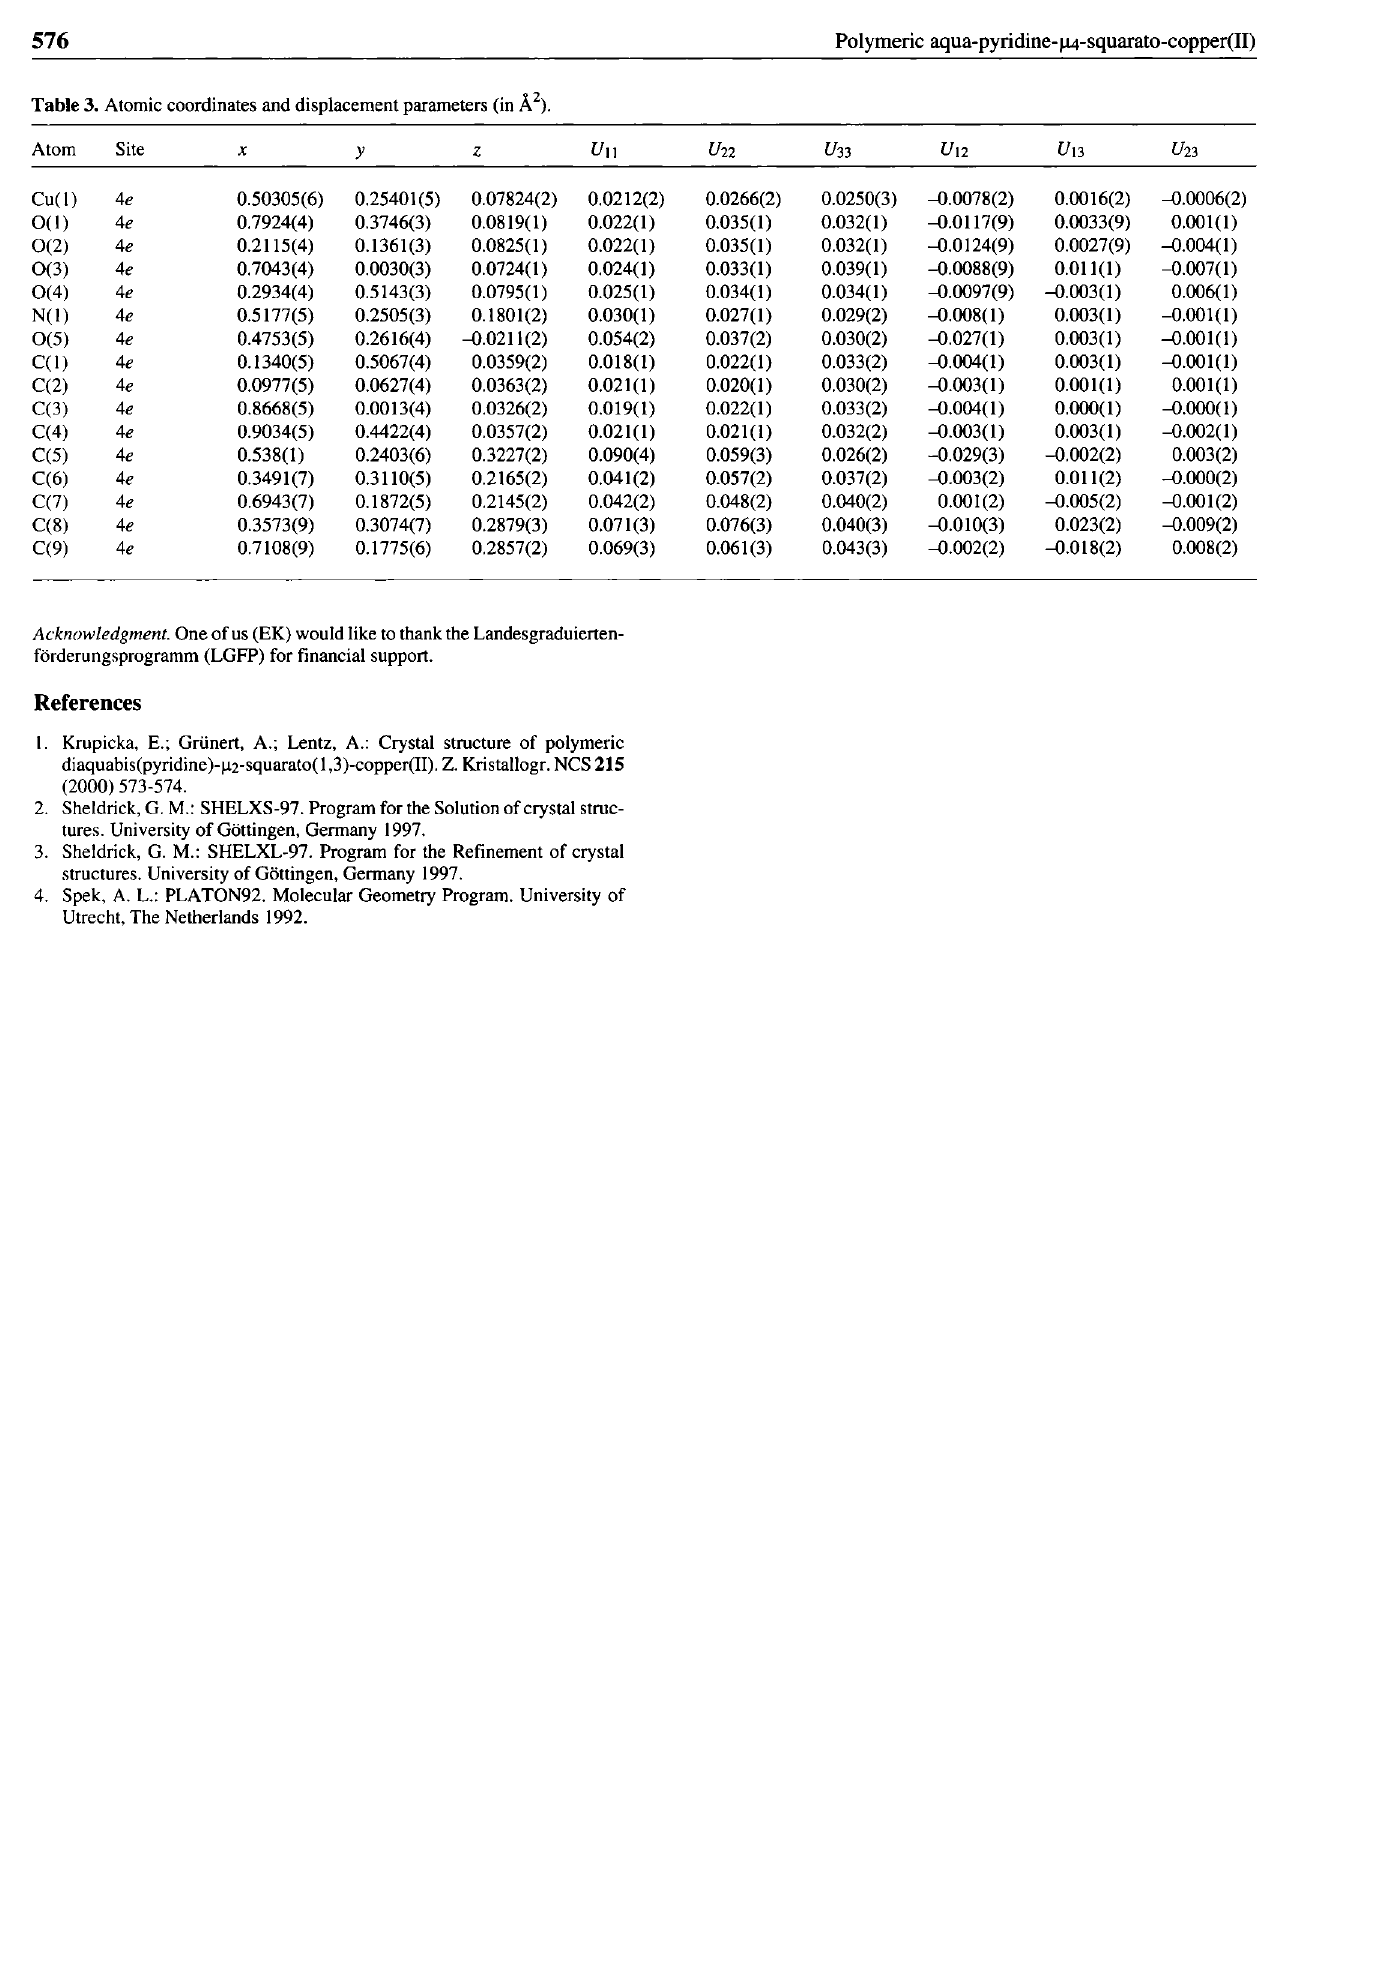
Table 3. Atomic coordinates and displacement parameters (in Â 2